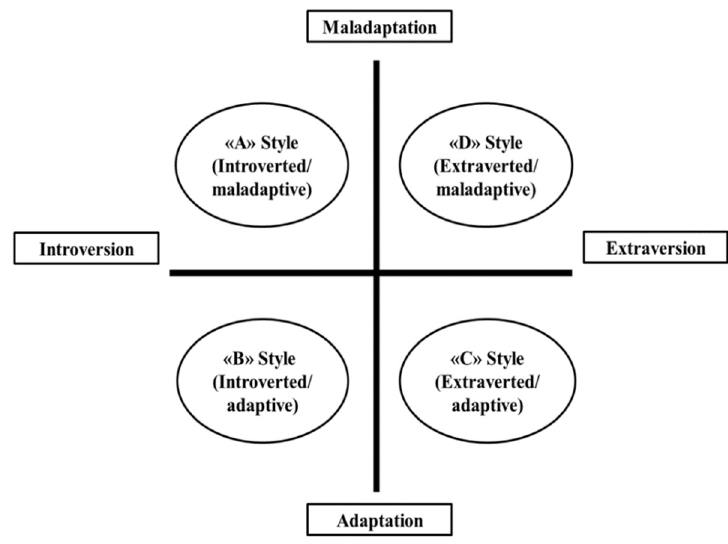
Figure 1. Figures Response Styles to the Pandemic and Lockdown(s) (RSPL).